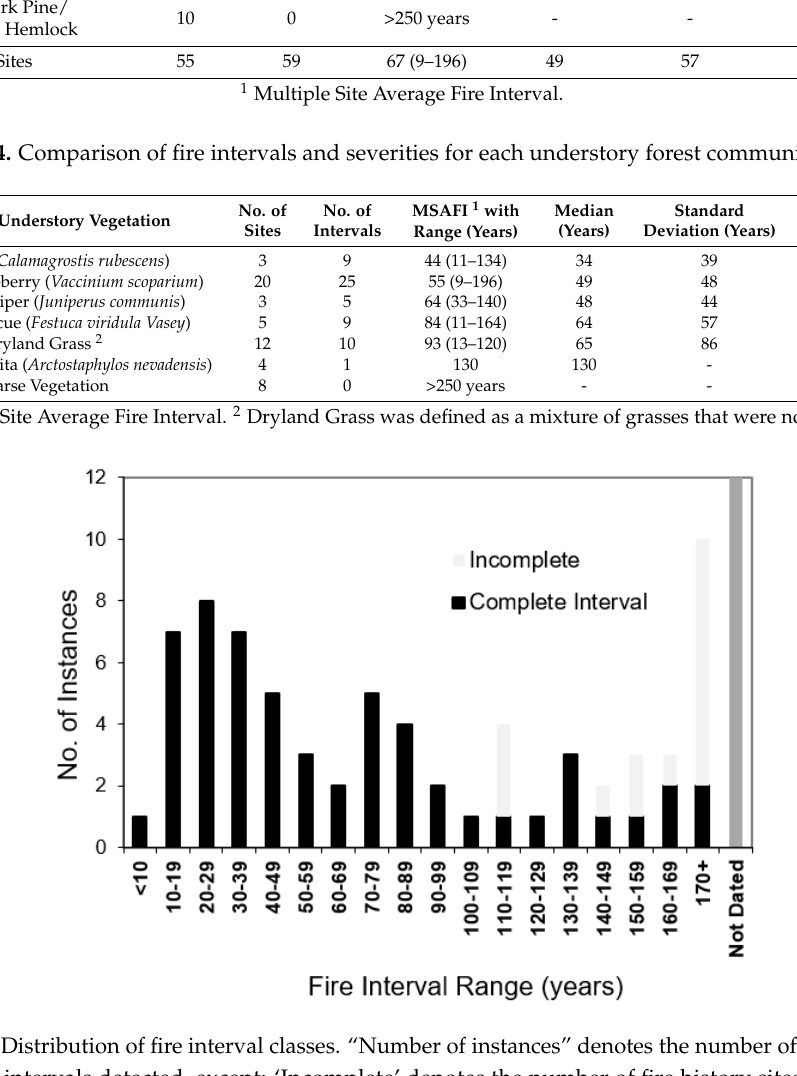
Figure 3. Distribution of fire interval classes. “Number of instances” denotes the number of individual complete intervals detected, except: ‘Incomplete’ denotes the number of fire history sites with only a single fire evident and are classed according to number of years since the fire date (as of 2003 or 2004), thus should be viewed as minimum values (years). Right-most bar denotes the number of sites that had inconclusive dendrochronological evidence.